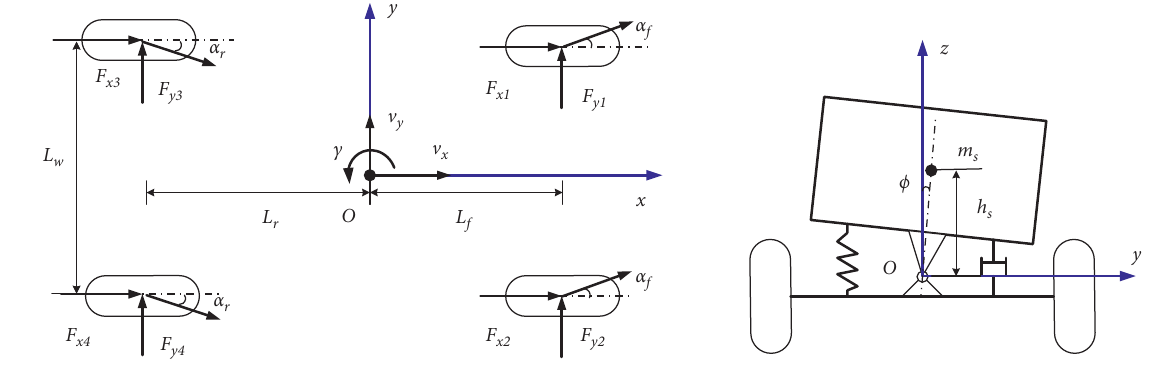
Figure 1: Diagram of the 8 DOF model.